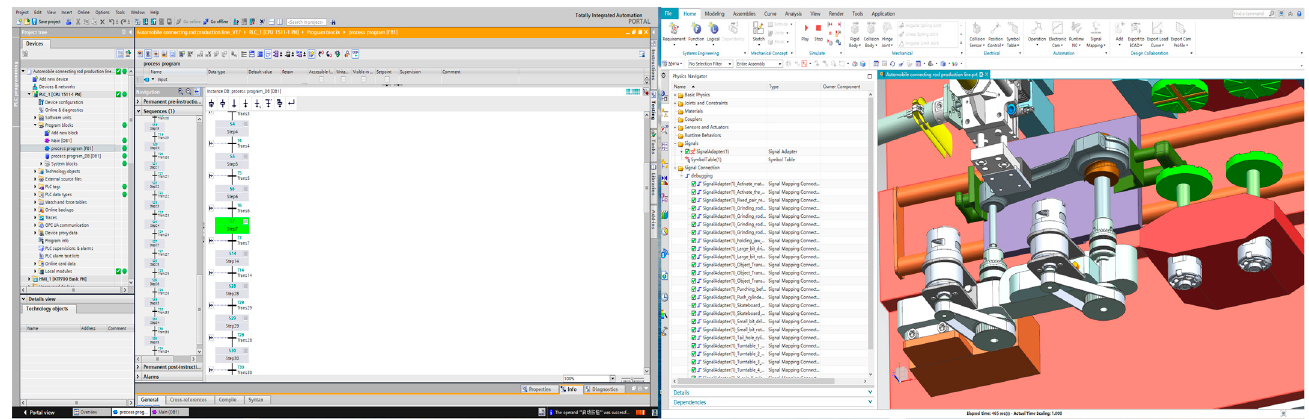
Figure 19. Real-time debugging of coarse boring large and small head holes.